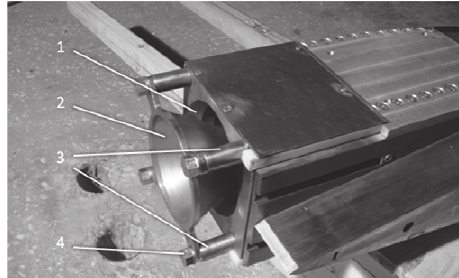
Figure 3. PSM measuring unit. Downstream view: 1 – casing; Figure 4. PSM throttling device: 1 – valve seat; 2 –